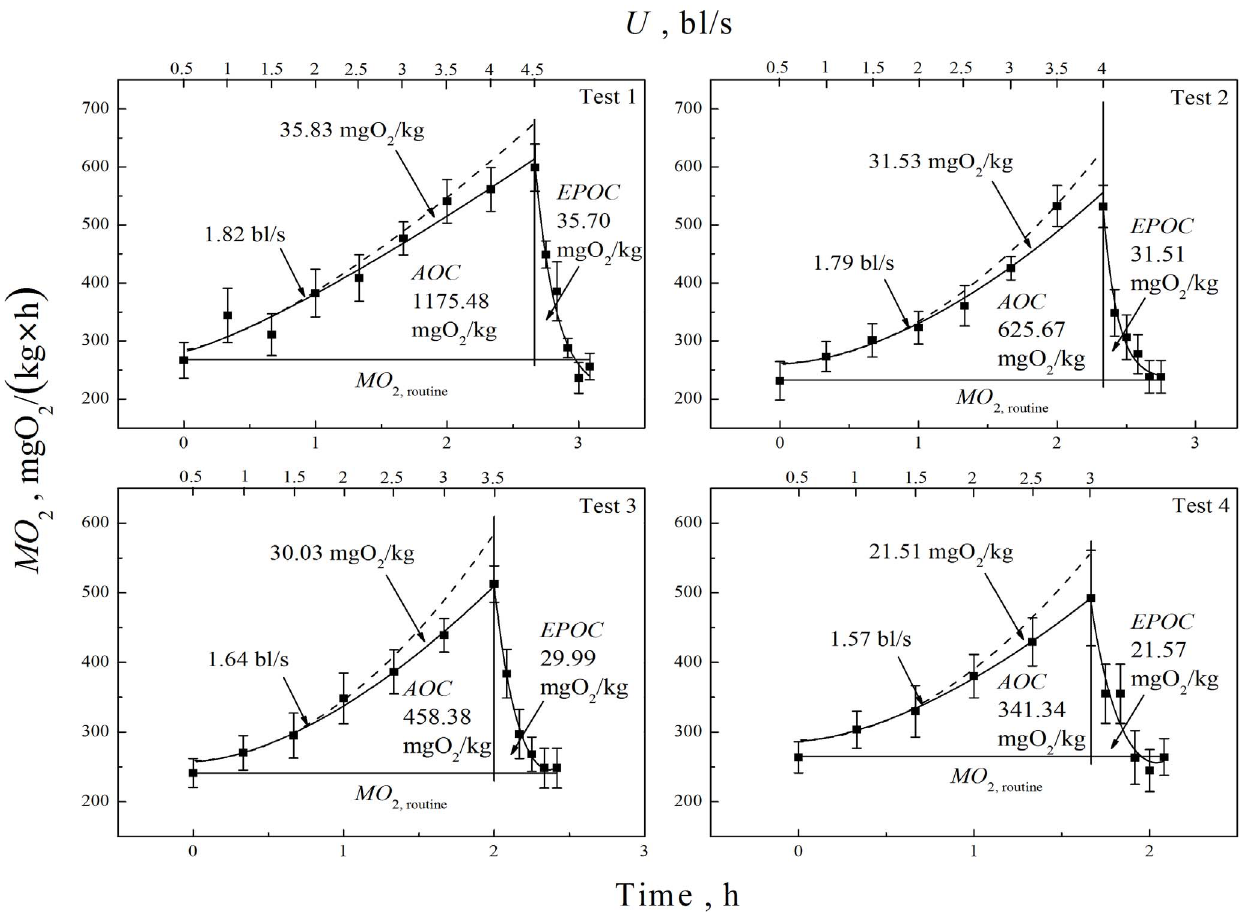
Figure 3. Variation of oxygen consumption rate ( MO 2 , mean ± S.E.) over time. Active oxygen consumption ( AOC ) is the difference between aerobic oxygen consumption and routine oxygen consumption during swimming period; excess post-exercise oxygen consumption ( EPOC ) is the difference between aerobic oxygen consumption and routine oxygen consumption during recovery from exhaustion.